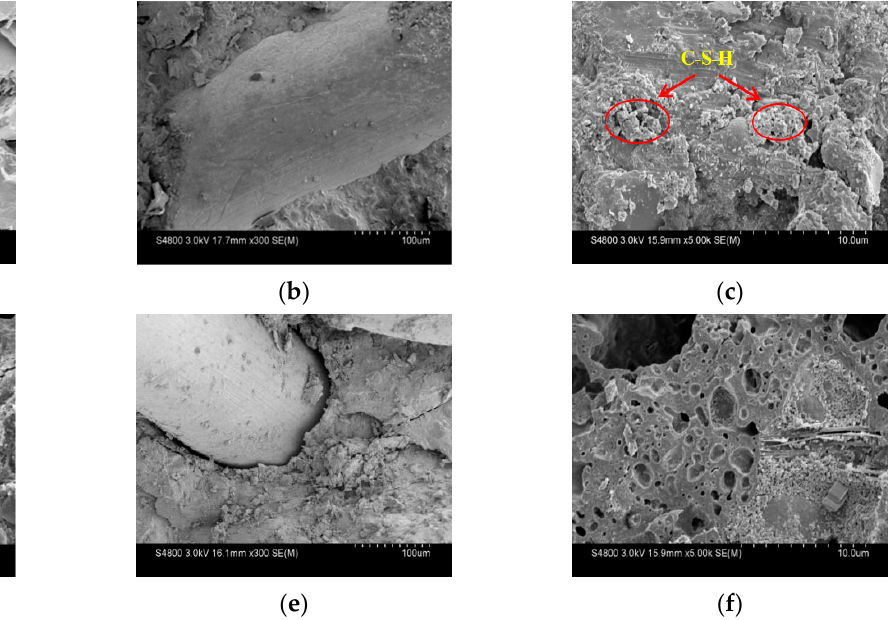
Figure 10. SEM images of manufactured sand UHPC samples under different curing methods. ( a ) RS ‐ SM; ( b ) MS ‐ SM; ( c ) MS ‐ CH; ( d ) MS ‐ SD; ( e ) MS ‐ SP; ( f ) MS ‐ SP.